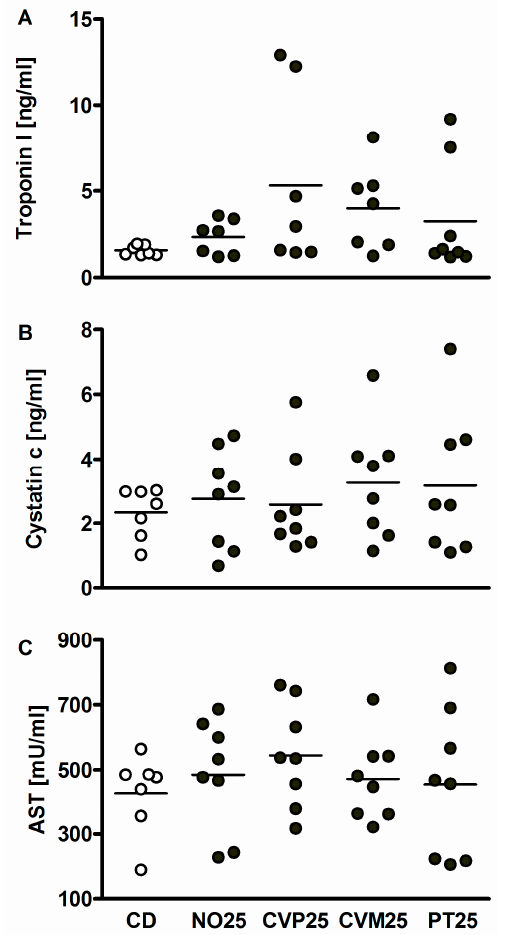
Figure 5. Toxicity markers for heart (cardiac troponin I, ( A )), kidney (cystatin c, ( B )) and liver (aspartate aminotransferase (AST), ( C )) were analyzed in the serum of C57BL/6 mice. The microalgae N. oceanica (NO), C. vulgaris phototrophic cultured (CVP), C. vulgaris mixotrophic cultured (CVM), P. tricornutum (PT) were supplemented to 25% for 14 days. Test diets were isocaloric and isoproteinogenic to the control diet (CD). Data are expressed as means ± SEM ( n = 7–8, no significant differences analyzed by ANOVA).